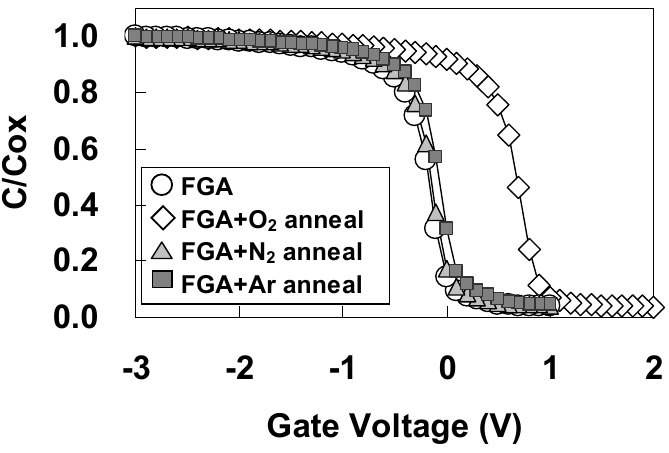
and Ar annealing. The 2 annealing are shown again for comparison. 2